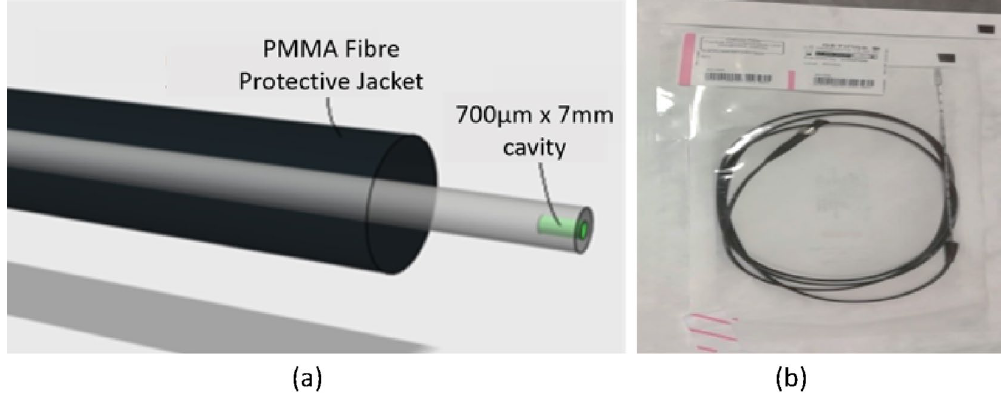
Figure 1. Optical fibre based radiation dosimeter: ( a ) schematic of sensor design, ( b ) optical fibre sensor within brachytherapy needle in the sterilized